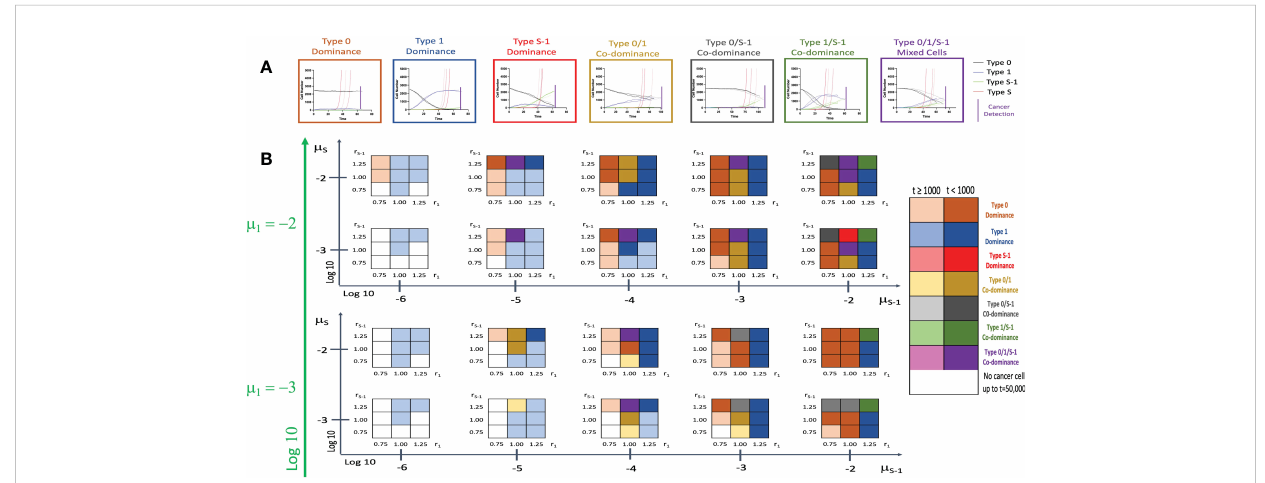
FIGURE 4 Patterns of tissue composition at cancer initiation with spatial structure. (A) Simulation studies with spatial structure show 7 patterns of cancer initiation. For each pattern, black, blue, green and red curves indicate Type 0, Type 1, Type S -1 and Type S cells, respectively. Each parameter set was simulated in triplicate (Joined, dashed, and long-dashed lines). (B) Panel showing patterns of tissue composition and time to detection using combination of various parameter sets. The de fi nitions of “ Dominance ” and “ Co-dominance ” are the same as those explained in Figure 2. Parameter values used are: N = 2,500; d = d s =1.0; r 0 = 1.0; r 1 = 0.75, 1.00 and 1.25; r S -1 = 0.75, 1.00 and 1.25; r S = 1.5; m 1 = 0.001 and 0.01; m S -1 = 0.000001, 0.00001, 0.0001, 0.001 and 0.01; m S = 0.001 and